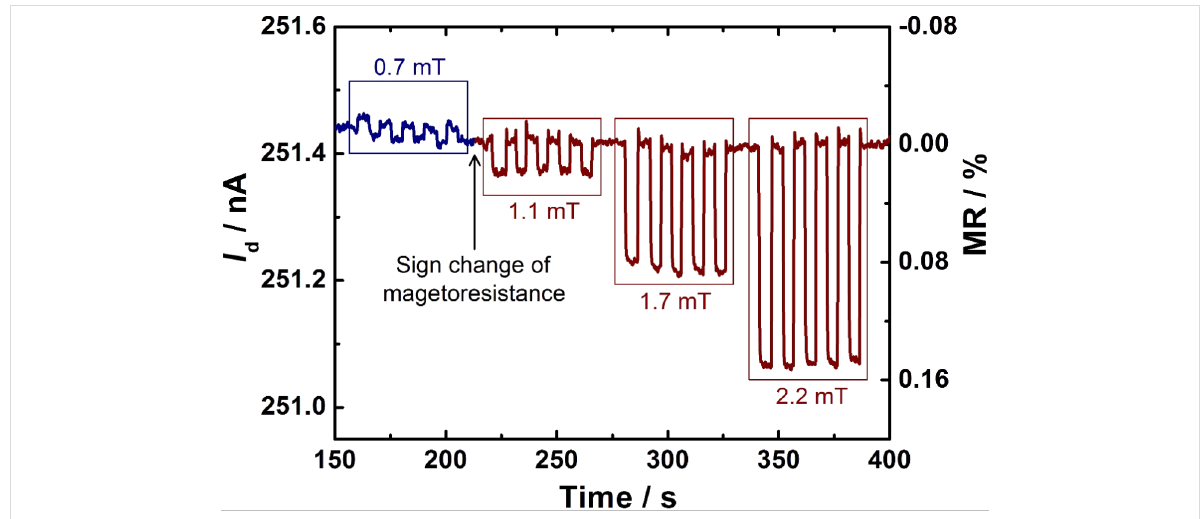
Figure 7: Experimental raw data covering ultrasmall magnetic-field effects including a MR sign-reversal. For B = 0.7 mT the I d is increased (high- lighted in blue) while I d decreases for larger magnetic fields (highlighted in red). The experiment was carried out for zero V g = 0, V d = − 2.5 V and a mixing ratio of 51:49.